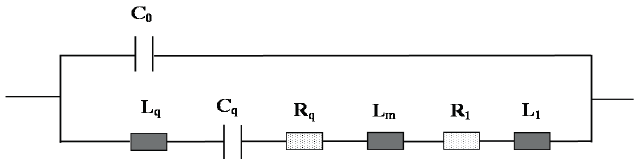
Figure 1. Equivalent circuit of a rigid layer-modified mQCM in liquid